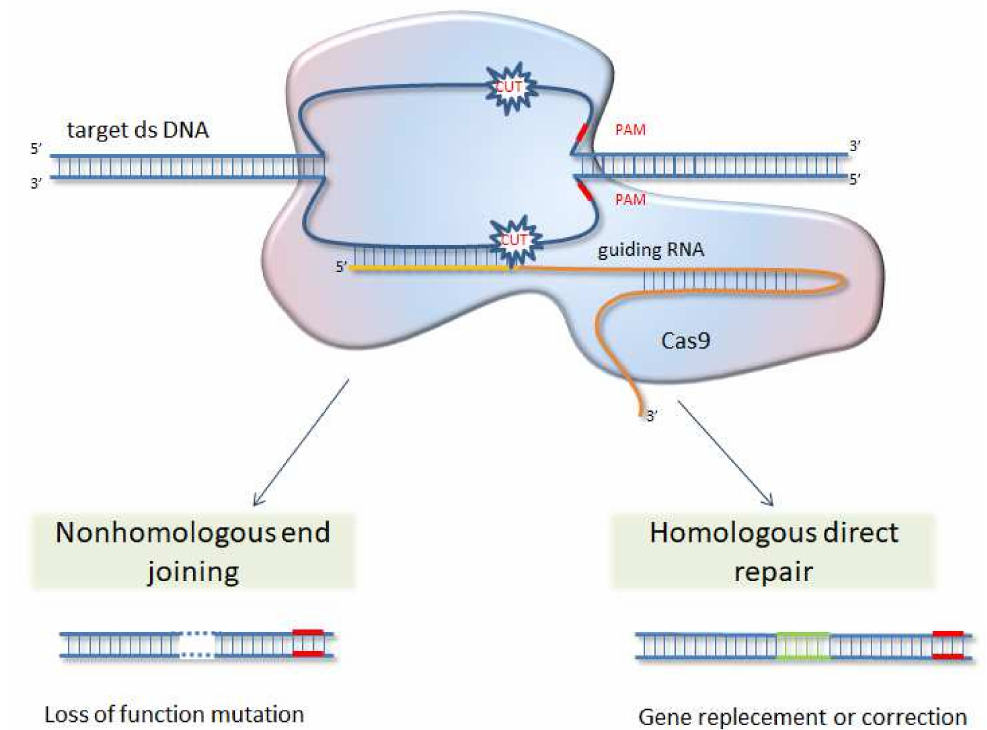
Figure 2. Scheme of CRISPR/Cas9 genome editing technology. Guide RNA, directed by PAM sequences near the targeted gene, lead Cas9 nuclease to altered DNA in desired location. Double strand breaks are repaired either by NHEJ or HDR mechanisms upon the existence of a donor template, which in result lead to deletion or insertion and gene knockout. NHEJ is more efficient than HDR, but may produce indel mutations, whereas HDR can provide a precise gene